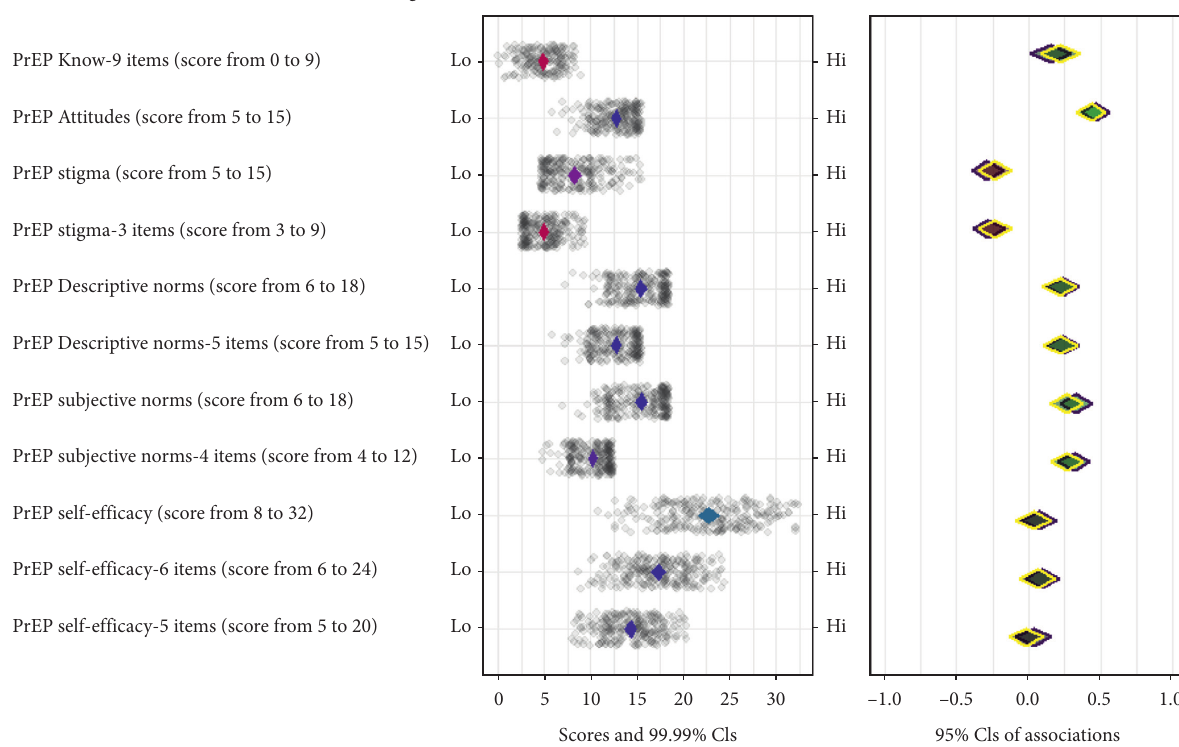
Figure 1: The output of the confidence interval-based estimation of relevance (CIBER) analysis regarding determinants of willingness (purple color) and intention (yellow color) to use PrEP among MSM. Diamonds in the left-hand panel indicate the means and corre- sponding 99% confidence interval of each scale’s scores (scales of PrEP attitudes, stigma, descriptive norms and subjective norms, and PrEP self-efficacy). Green diamonds represent MSM who have a willingness and intention to use PrEP, and purple diamonds represent those who did not. Diamonds in the right-hand panel represent the 95% confidence intervals of the associations (Cohen’s d) between each determinant and willingness and intention to use PrEP. Willingness and intention to use PrEP” was dichotomized into two categories:1 � to definitely yes and probably yes and 0 � all other answer options: neutral, probably not, definitely